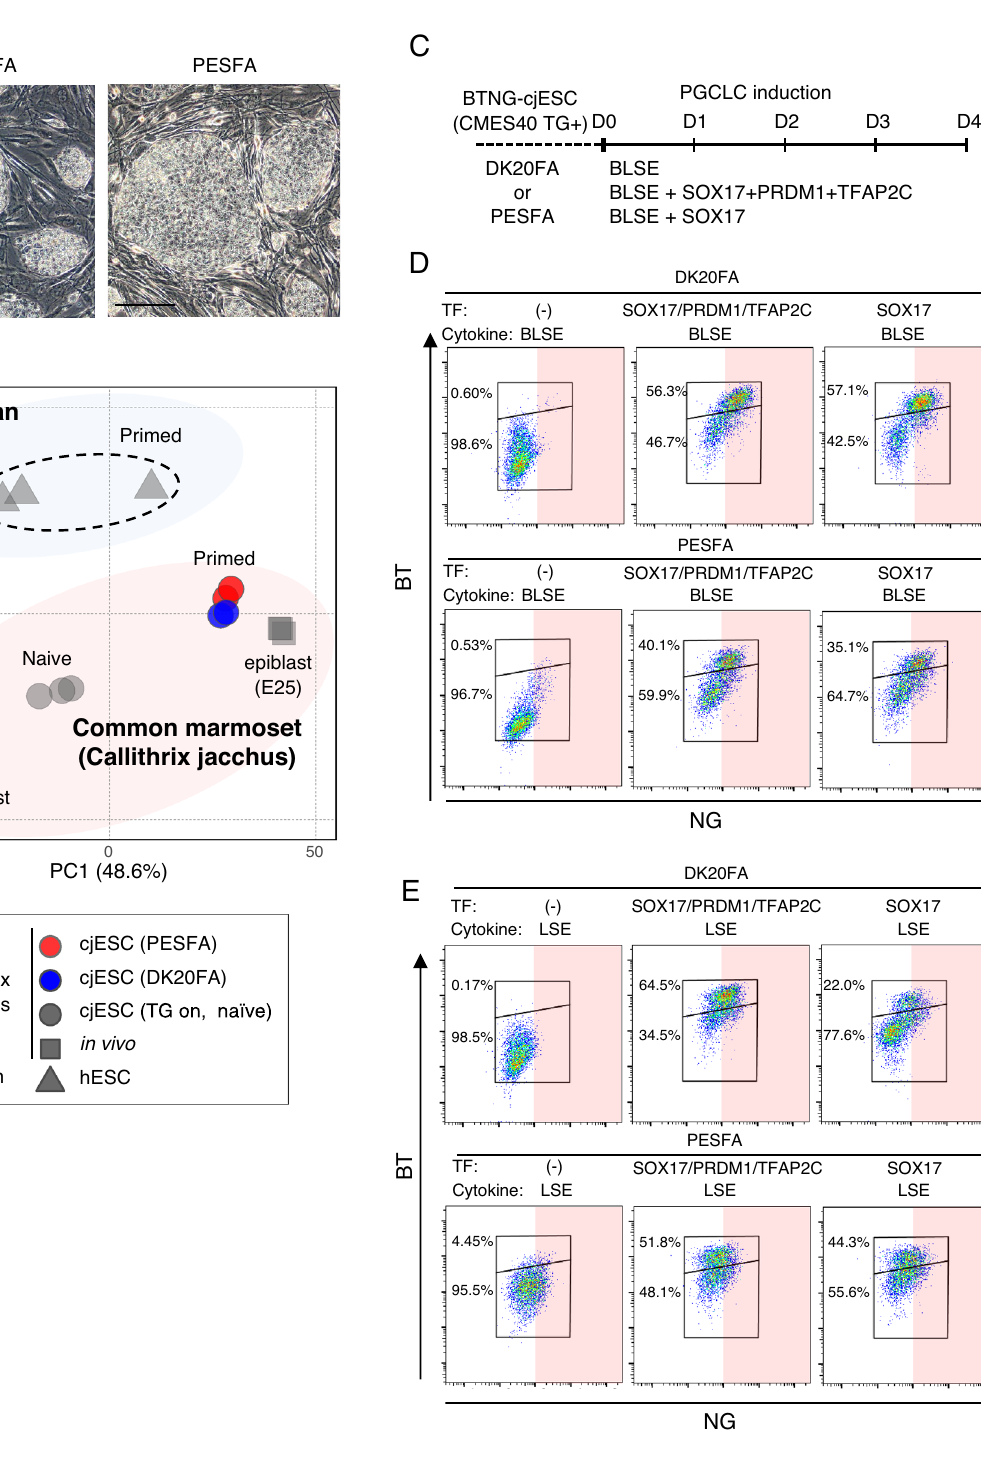
Figure 1. Induction of BTNG-positive cells by exogenous SOX17 expression with BMP4. ( A ) Morphology of cjESCs cultured on MEF in DK20FA and PESFA. Scale bar, 200 μm. ( B ) PCA of the gene expression profiles of pluripotent cell populations in common marmosets and humans. The genes used for the PCA were 839 ortholog genes annotated in both the common marmosets and humans, out of 886 differentially expressed genes between human naïve and primed ESCs 30 . The transcriptome profiles of common marmoset blastocysts, epiblasts and naïve ESCs were used 31 . ( C ) A schematic time course for PGCLC induction with or without exogenous SOX17 expression and BMP4. ( D ) FACS analysis of BTNG-positive cell induction with overexpression of transcription factors (TFs) and BLSE at day 4. ( E ) FACS analysis of BTNG-positive cell induction with overexpression of TFs and LSE at day